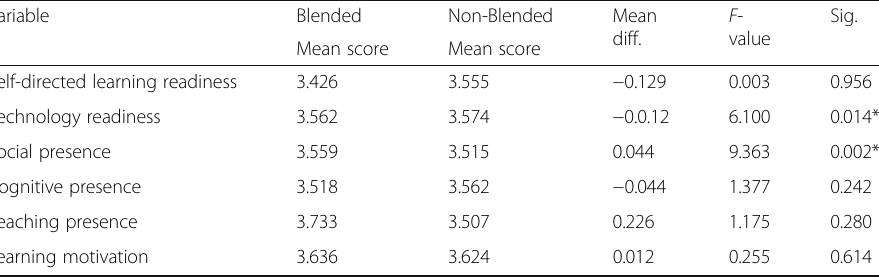
Table 6 BL group and NBL group mean comparison